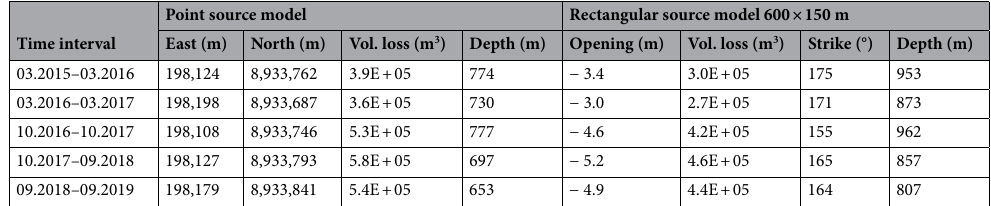
Table 1. Elastic modelling parameters for point source model and 600 × 150 m rectangular crack source model for five-time intervals.